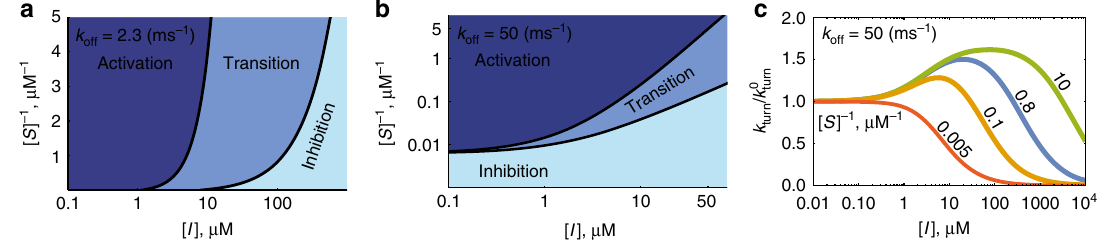
Fig. 6 The emergence of inhibitor – activator duality depends on substrate concentration. a , b Phase diagrammatic representation of enzymatic turnover for two different instances of the two-state model. Here, activation is the phase where turnover is higher than its value in the absence of inhibition (i.e., when [ I ] = 0), and any increase in inhibitor concentration increases turnover further; transition is the phase where turnover is still higher than its value in the absence of inhibition, but where further increase in inhibitor concentration results in a decrease of the turnover rate; and inhibition is the phase where turnover is lower than its value in the absence of inhibition, and any increase in inhibitor concentration decreases turnover further still. Keeping substrate concentration fi xed, and varying the concentration of the inhibitor, turnover attains a maximum when crossing the line which separates the activation and transition phases, and re-attains its value at [ I ] = 0 when crossing the line which separates the transition and inhibition phases. Plots were made with the ¼ 50 ms (cid:4) 1 , k 2 ð Þ ¼ 0 : 5 ms (cid:4) 1 , p ¼ 0 : 1 ; k ¼ 0 : 2 μ Mms ð Þ (cid:4) 1 ; k ESI ¼ 30 μ Mms ð Þ (cid:4) 1 , k ESI ¼ 50 ms (cid:4) 1 and two different values of k following parameters: k 1 ð Þ on off cat cat on off (indicated in the top left corner of each panel). c Lateral cross-sections through b showing the turnover rate, normalized by its value in the absence of inhibition, as a function of [ I ]. The activation phase in b corresponds to the ascending branch of the curves in c , whereas the transition and inhibition phases correspond to the part of the descending branch of the curves which respectively lies above, and below, unity. Substrate concentrations, corresponding to where cross-sections in b were taken, are indicated next to each that relates to the kinetics of the inhibited enzyme. On the right-